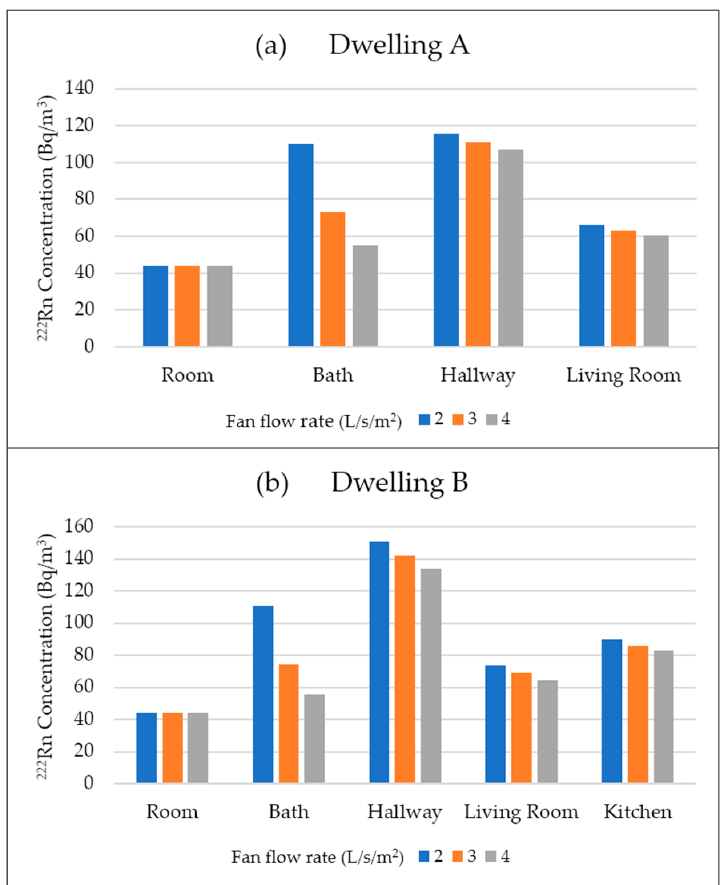
Figure 5. Evolution of radon concentration in ( a ) dwelling “A” and ( b ) dwelling “B”, considering the variation of the bathroom fan flow rate. The results were obtained from simulations using the CONTAM software following the methodology described in the paper.